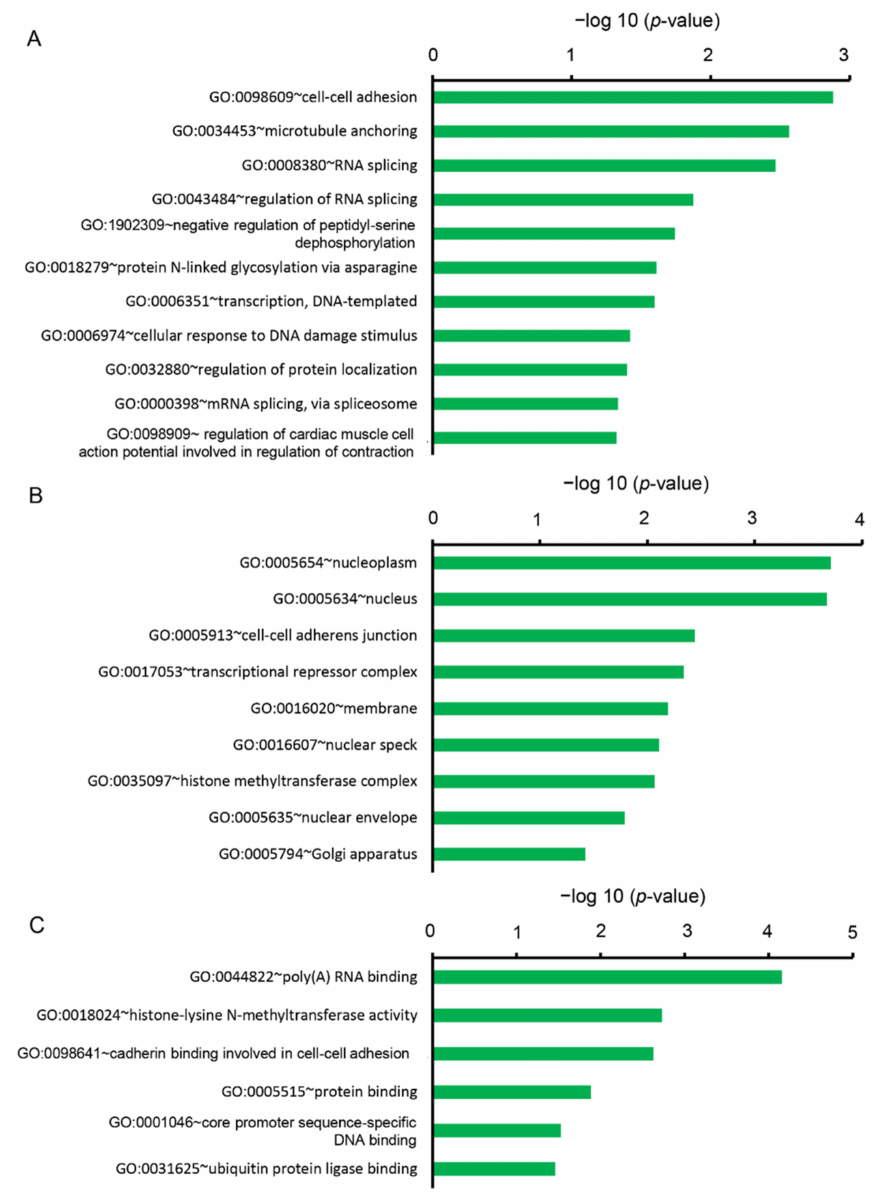
Figure 3. Functional analysis of downregulated DEGs between Cy3G-treated and untreated hAECs on day 7 by DAVID represented ( A ) significantly enriched biological process, ( B ) cellular components, and ( C ) molecular functions. The horizontal axis corresponds to − log10 p